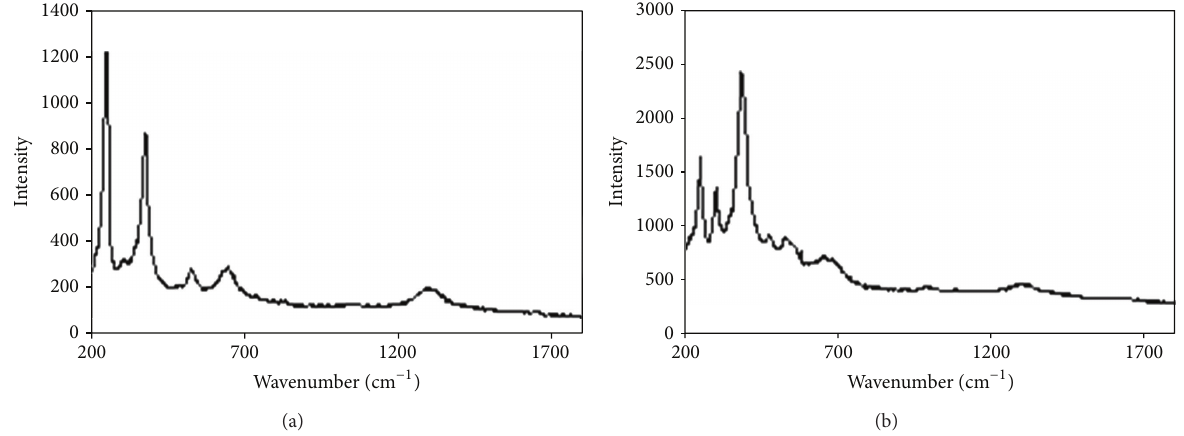
Figure 1: Raman spectra of (a) specimen exposed at Cubat˜ao, for three months, showing peaks characteristic of lepidocrocite ( 𝛾 -FeOOH) and (b) specimen exposed for one month at Paula Souza, showing peaks typical of goethite and lepidocrocite.